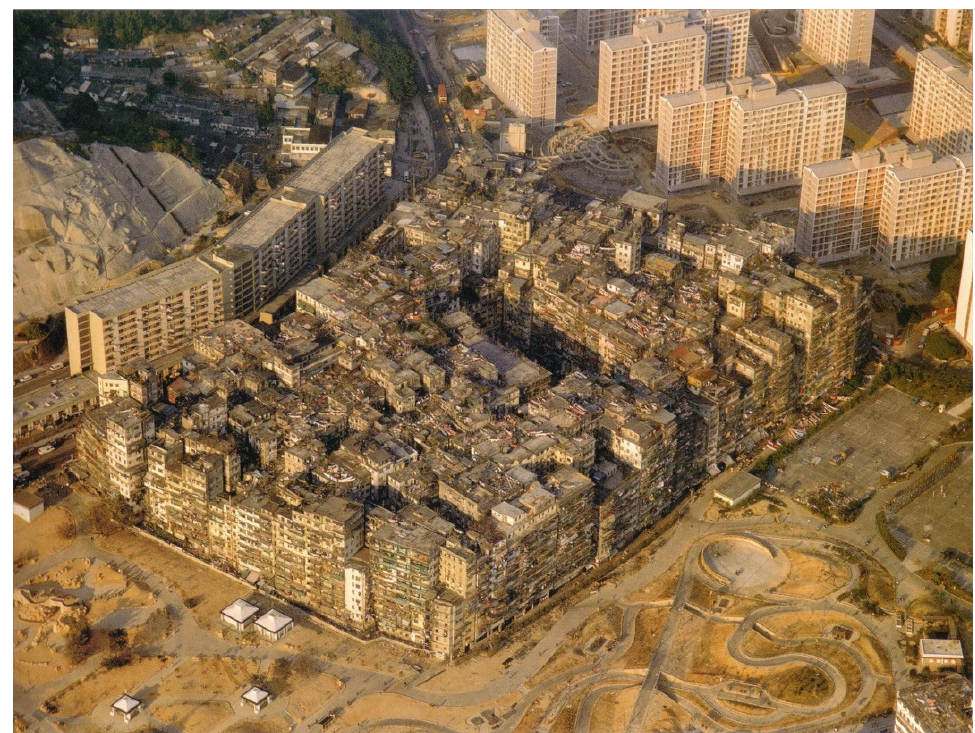
Figure 4. An aerial view of KWC in 1989 (https://commons.wikimedia.org/wiki/File:KWC_-_1989 _Aerial.jpg, author: Ian Lambot, under CC BY-SA 4.0, accessed 11 March